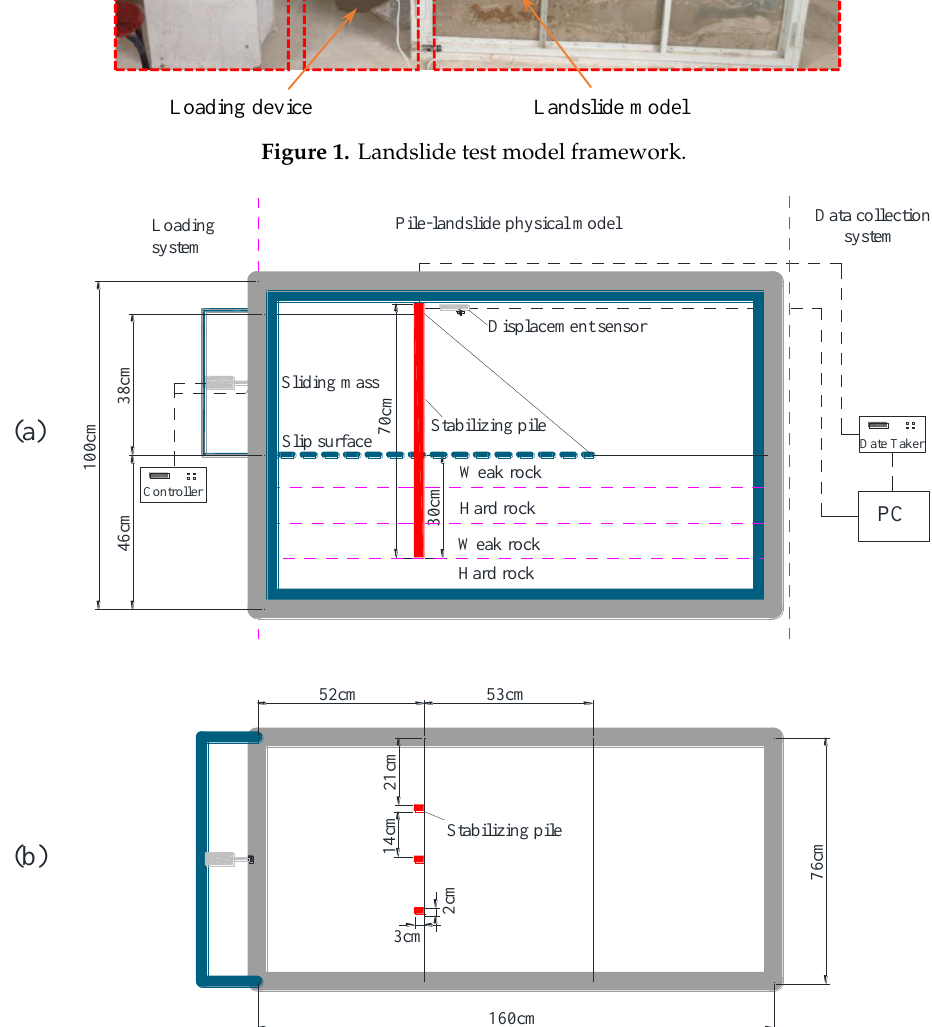
Figure 2. Functional block diagram of the pile–landslide physical model: ( a ) side view ( b ) top view.